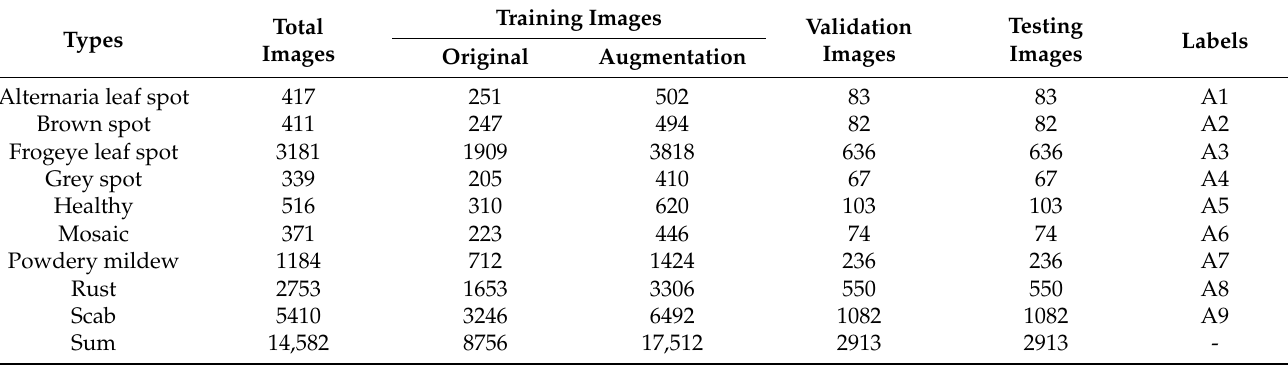
Table 2. Number of images for training, validation, and